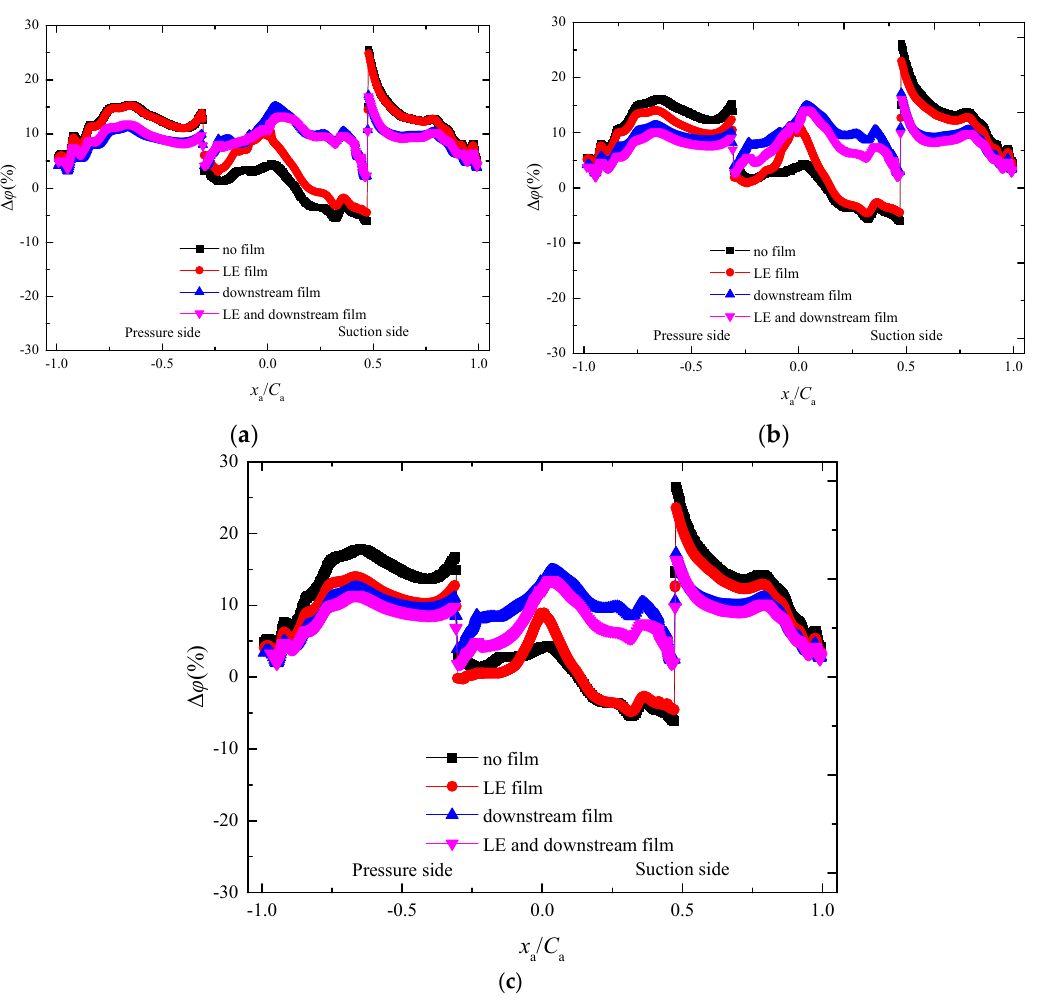
Figure 14. Overall cooling effectiveness increment distribution comparisons for different cases. ( a ) z = −19.3 mm, ( b ) z = 0 mm, ( c ) z = 19.3 mm.